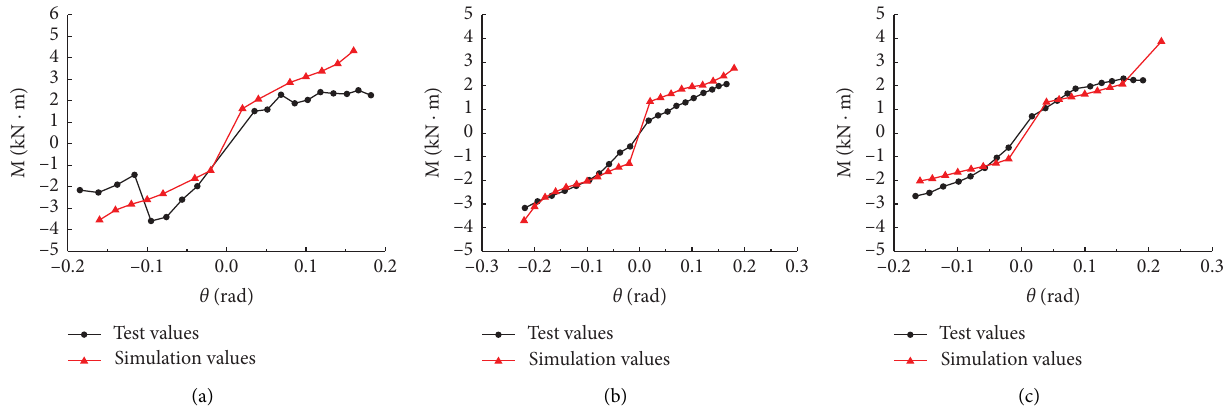
Figure 21: Comparison of the moment-rotation backbone curves of middle joints of steel plate reinforced: (a) Tou mortise-tenon joints. (b) Ban mortise-tenon joints. (c) Dovetail mortise-tenon